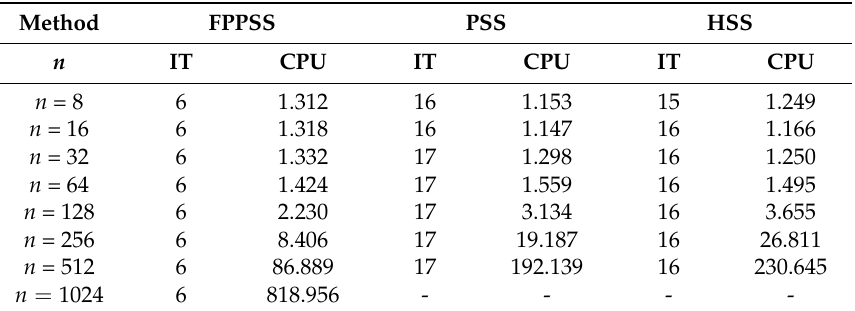
Table 1. IT and CPU for four parameters positive and skew-Hermitian splitting (FPPSS), positive and skew-Hermitian splitting (PSS), and Hermitian and skew-Hermitian splitting iterative method (HSS) for Example 1 when using experimental quasi-optimal parameters.